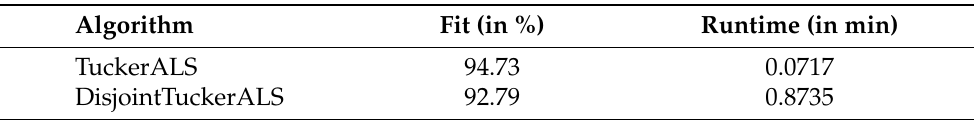
Table 14. Comparison of fit and runtime for simulated